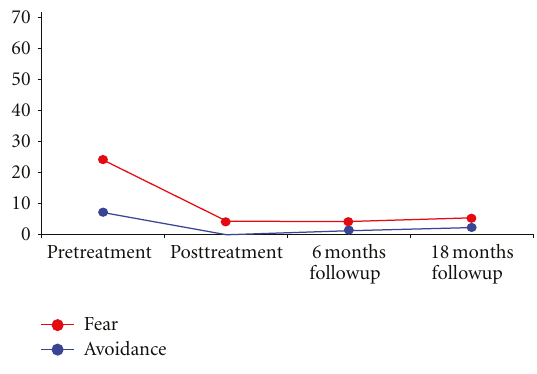
Figure 3: Liebowitz Social Anxiety Scale (LSAS) pre- and posttreat- ment and